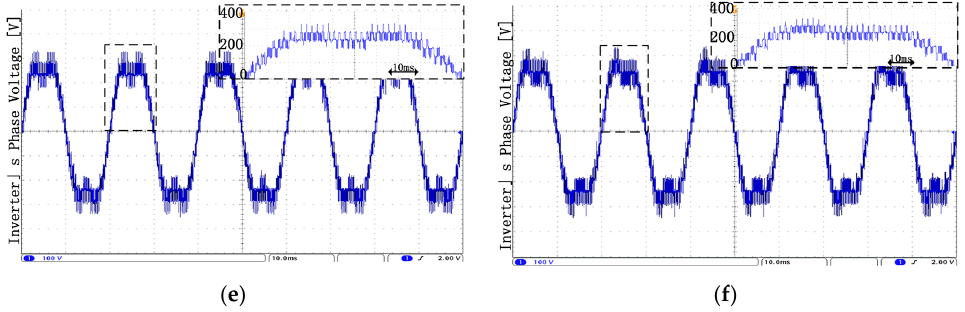
Figure 11. Experimental results in Case 1: the ( a ) grid voltages and currents; ( b ) modulating waveforms under different control strategies; ( c ) output phase voltages in conventional fault-tolerant control; ( d ) output phase voltage in FPSC; ( e ) output phase voltage in the THI; ( f ) output phase voltage in hybrid compensation control.